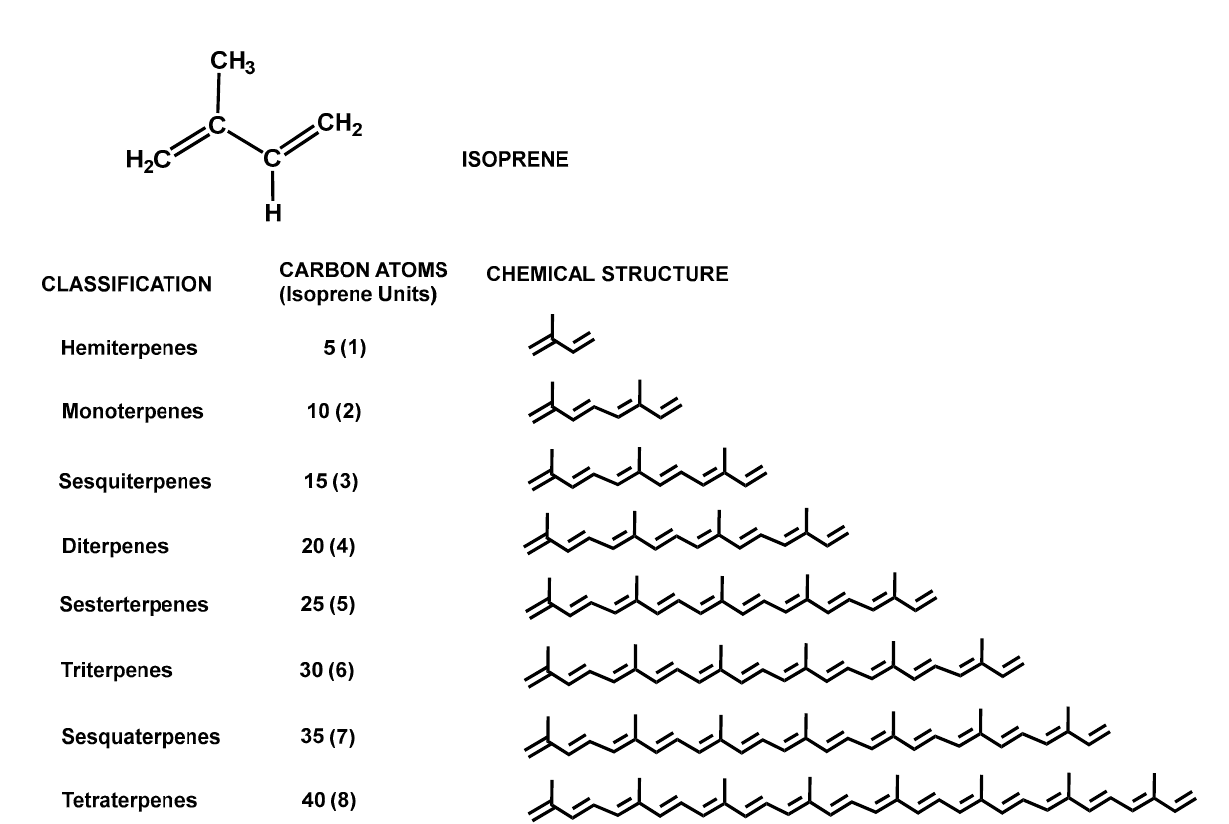
Figure 5. Chemical structure of isoprene and classification of terpenes according to the number of isoprene